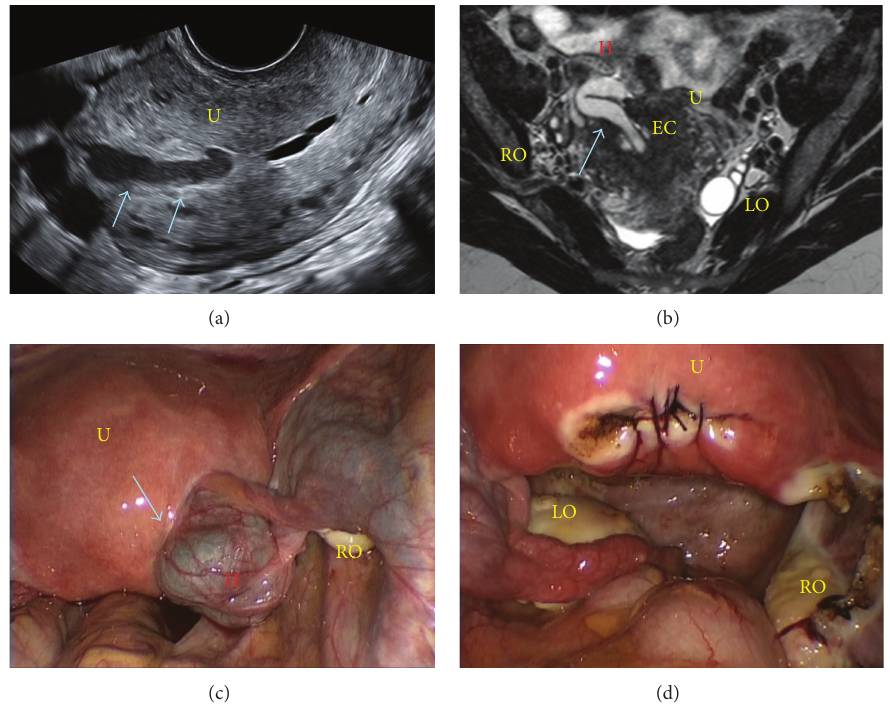
Figure 1: (a) Transvaginal ultrasound showing a hypoechoic structure (blue arrows) within the uterus (U). (b) Pelvic MRI demonstrating a herniation (blue arrow) of the right hydrosalpinx (H) through the uterine wall (U) going up to the endometrial cavity (EC). Both the right (RO) and the left (LO) ovaries were normal. (c) Laparoscopic visualization of the pelvic cavity: the hydrosalpinx (H) is incarcerated (blue arrow) in the uterus (U), and the right ovary (RO) is normal. (d) Final aspect of the procedure: uterus (U), left ovary (LO), and right ovary